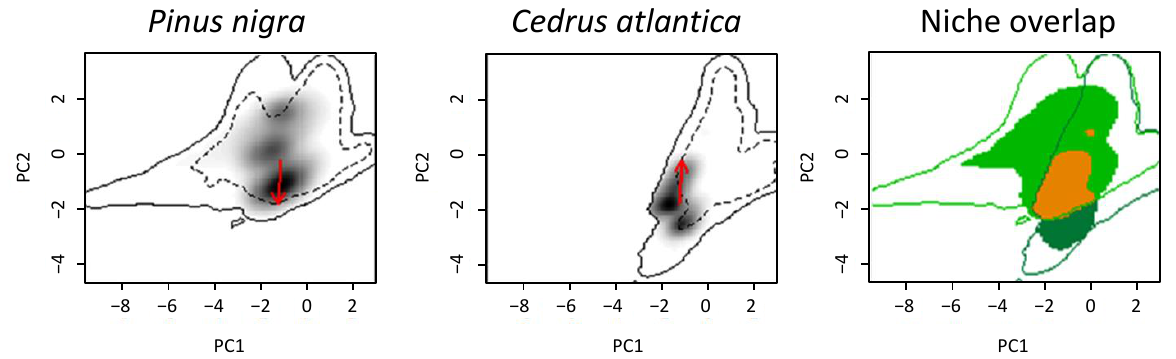
Figure 4. Niche overlap in environmental space. The solid line delimits the surrounding environment and the discontinuous line 50% of its area. The arrows show the relative displacement between the centroids of the niches in the overlap analysis. The overlap diagram shows the niches of Pinus nigra and Cedrus atlantica (polygons in light and dark green, respectively). The reddish polygon indicates the common niche